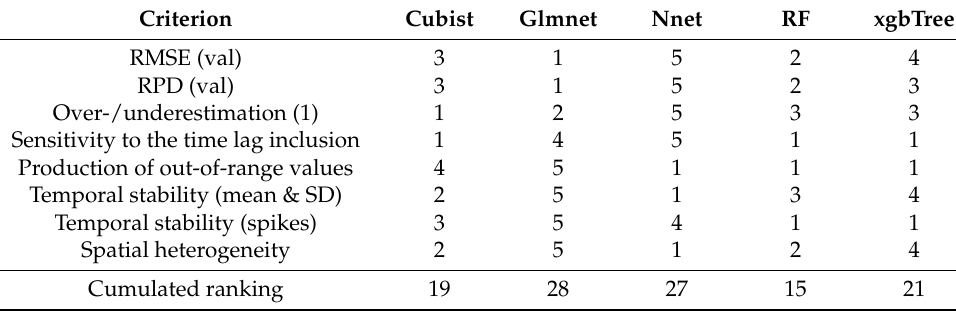
Table 8. Ranking of the most promising models according to multiple criteria. Criterion Cubist